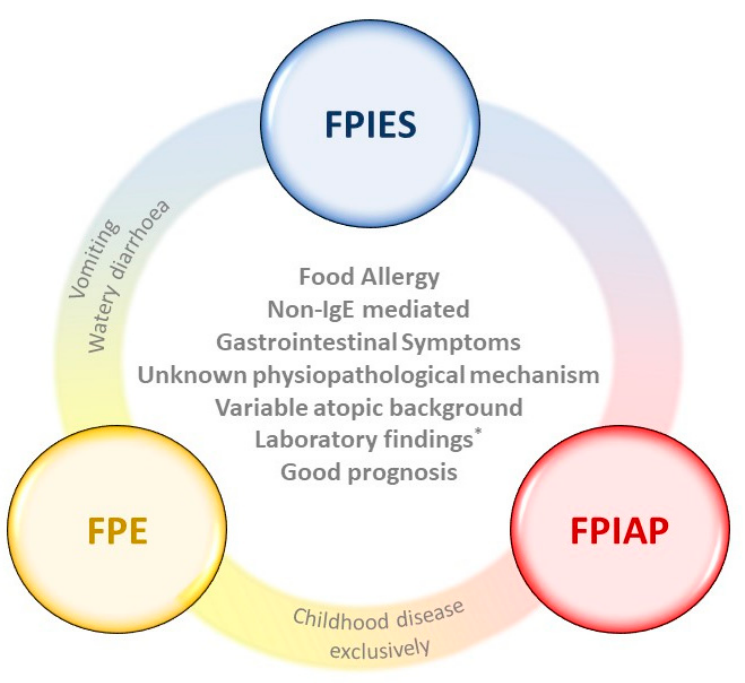
Figure 1. Description of differences and similarities between FPIES, FPE, and FPIAP. FPIES: food protein-induced enterocolitis syndrome; FPE: food protein-induced enteropathy; FPIAP: food protein-induced allergic proctocolitis. * Laboratory findings (e.g., anemia, iron deficiency, eosinophilia, rectal bleeding, etc.) are similar as long as the food is not withdrawn from the diet.